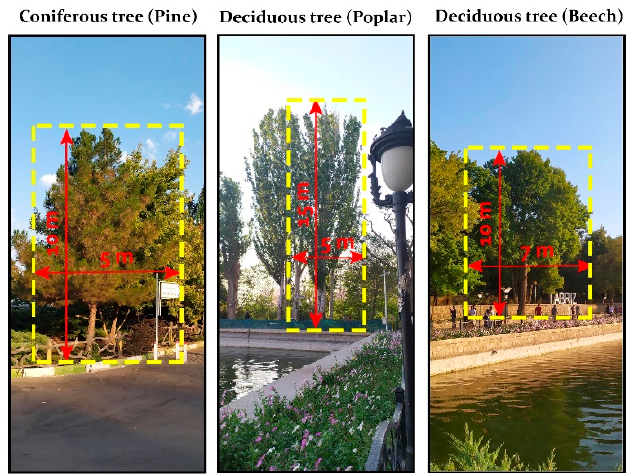
Figure 3. A view of three different trees planted in El-Golu park (trees exemplary dimensions in red).